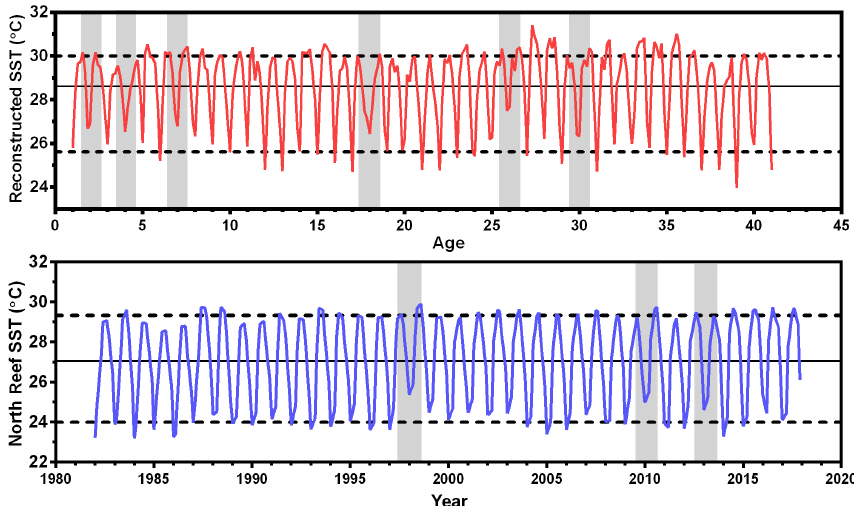
Figure 5. Reconstructed SST around 3700 years ago (red), compared with the North Reef SST from 1982 to 2017 (blue). Dotted lines represent the average maximum and minimum SST. The gray field represents extreme El Ninõ winter